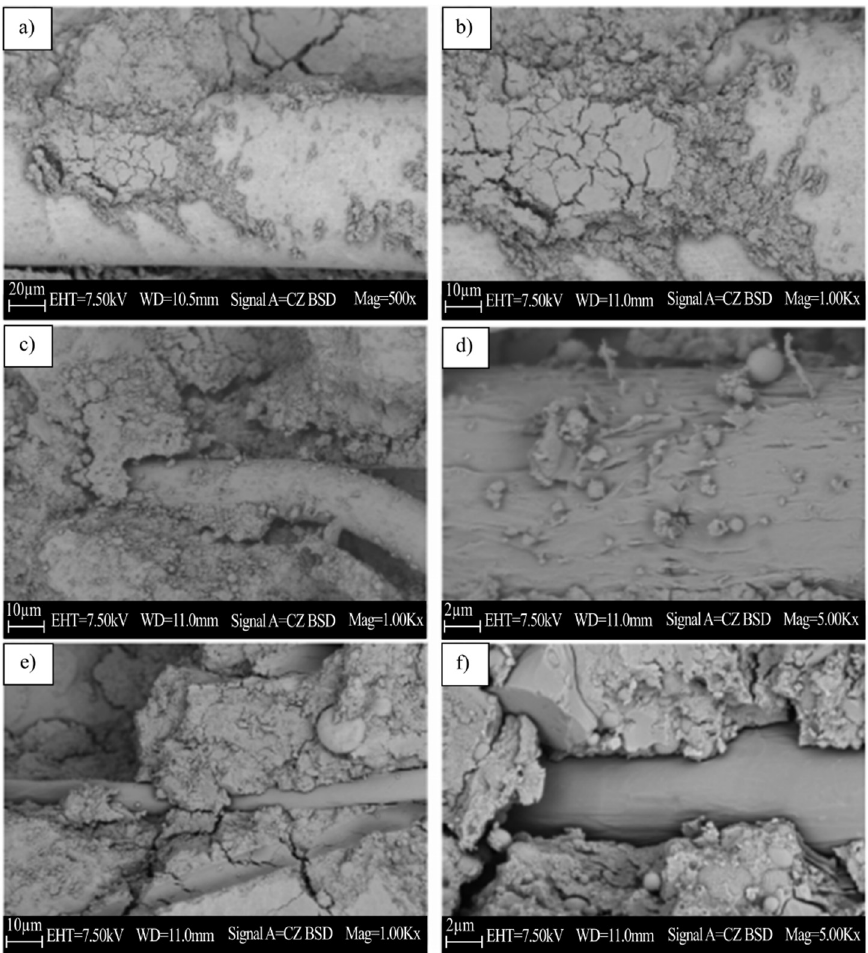
Figure 6. SEM micrographs the investigated ( a , b ) steel fibers sample, ( c , d ) polyvinyl alcohol fibers sample, ( e , f ) polypropylene fibers sample [2].